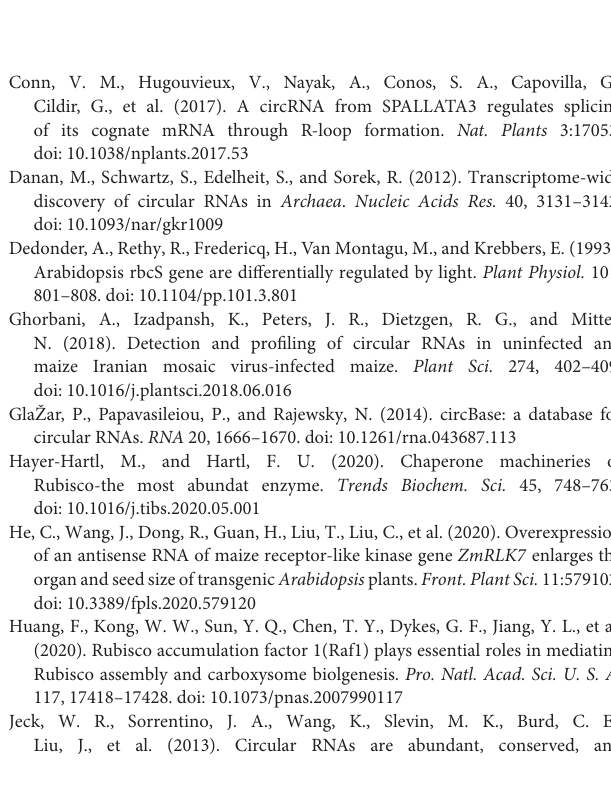
Supplementary Figure 1 | Library preparation for circRNA sequencing. Supplementary Table 1 | Sequences of circular RNAs encoding the antisense RBCS genes. Supplementary Table 2 | Primers used in this